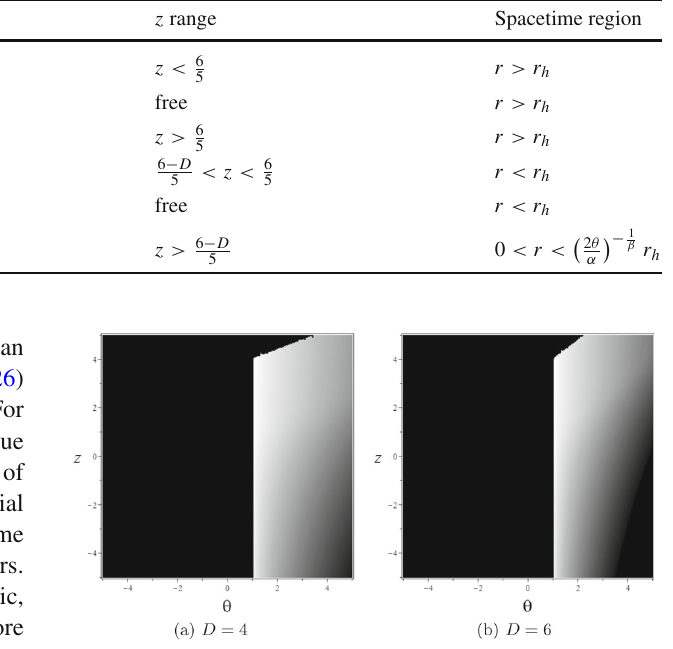
Fig. 2 Adensityplotofthenumericalvaluesofthescalarfield’sprofile in the outside of the horizon (for an exemplifying fixed r > r h ) is displayed.Thecompletelyblackpatchesdepictregionsintheparameter space where the field takes complex or unbounded (divergent) values. We show the D = 4 , 6 cases from left to right for illustration